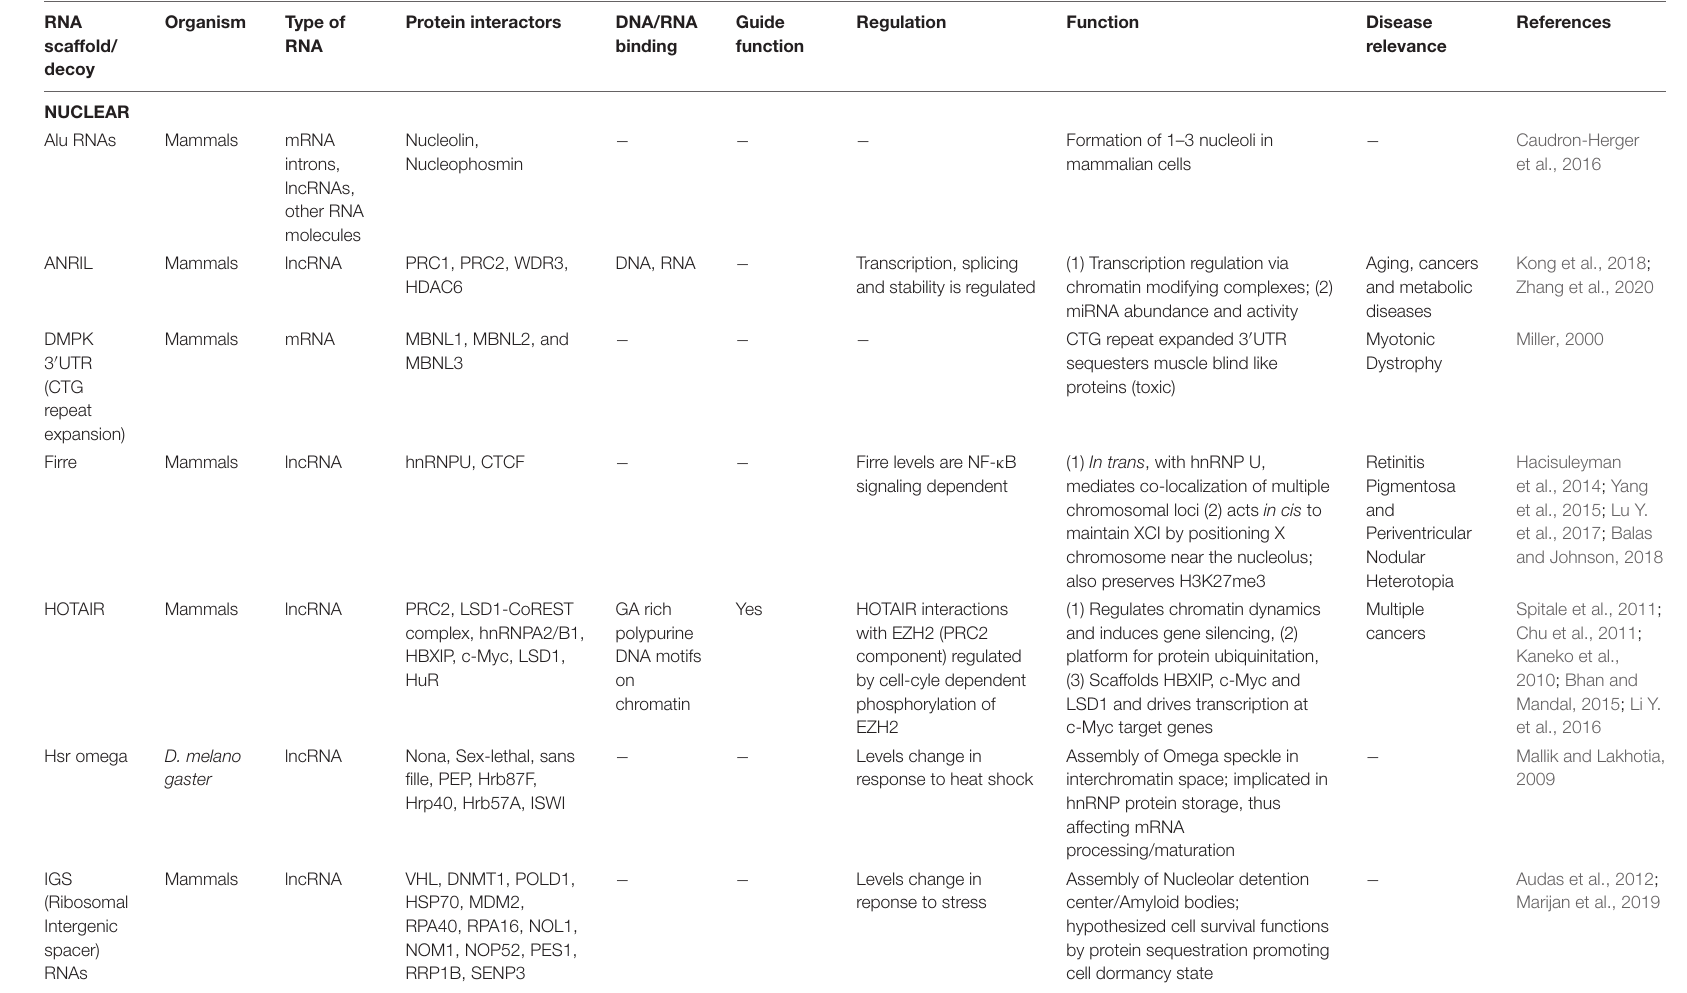
TABLE 1 | Select examples of nuclear and cytoplasmic RNA scaffolds and decoys. RNA scaffold/